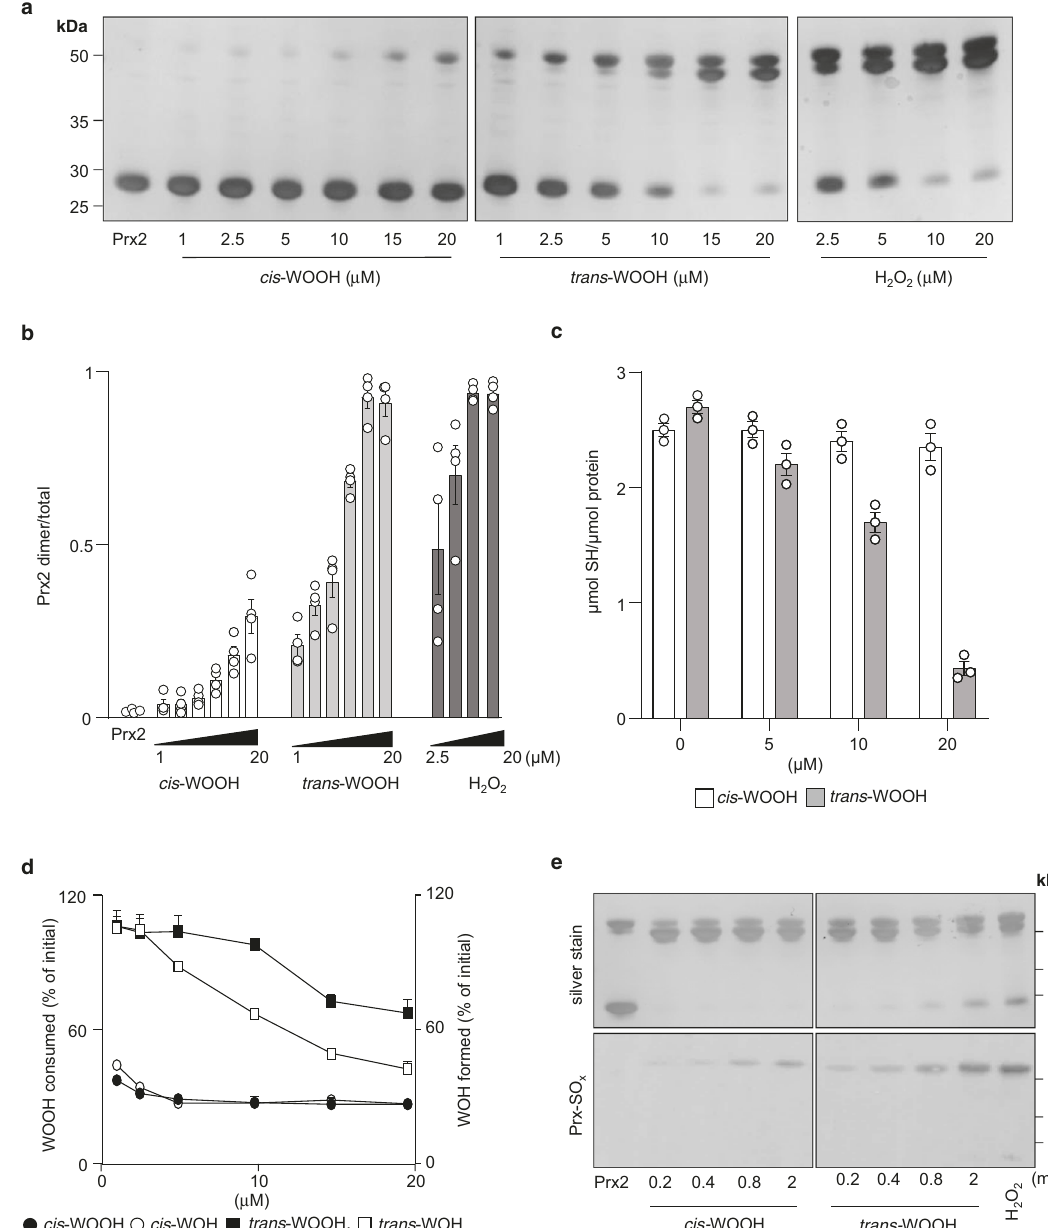
Fig. 4 Differences in dimerization, thiol, and hydroperoxide consumption during the reaction of Prx2 with cis - versus trans -WOOH. a Concentration- dependent reactions of cis- and trans- WOOH, and H 2 O 2 (control) with pre-reduced His-tagged Prx2 (20 μ M). Reactions were stopped after 10 s using NEM (50 mM). b Quanti fi cation of silver-stained Prx2 dimer and monomer bands in ( a ) with results expressed as ratio of Prx2 dimer-to-total Prx2, n = 4 independent experiments. c Quanti fi cation of free thiols after incubation of pre-reduced His-tagged Prx2 (20 μ M) with cis -WOOH or trans -WOOH for 10 s before addition to 1 mM 5,5 ′ -dithio- bis (2-nitrobenzoic acid), DTNB, n = 3 independent experiments. d Quanti fi cation of WOOH consumption and WOH formation in the presence of pre-reduced His-tagged Prx2 (20 μ M) as determined by LC-MS/MS. Data are expressed as percentage of hydroperoxide consumed and corresponding alcohol formed relative to the initial hydroperoxide concentration, n = 3 independent experiments. e Absence of hyperoxidation of His-tagged Prx2 (20 μ M) upon reaction with cis -WOOH or trans -WOOH. Samples were assessed in duplicates using non-reducing SDS- PAGE, with proteins on one gel silver stained and the other transferred to a polyvinylidene di fl uoride membrane before probing with an antibody speci fi c for Prx-SO 2/3 . Data shown are representative of three ( a ) or two ( e ) separate experiments. Data in b , c , and d are shown as mean ± SEM. Uncropped blots and source data are provided as a Source data fi